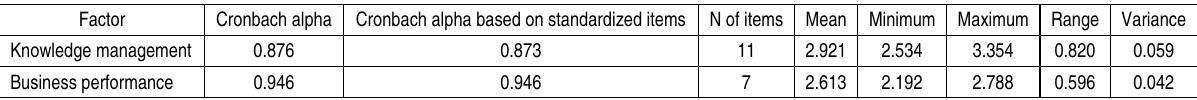
Table 3. Results of factor reliability